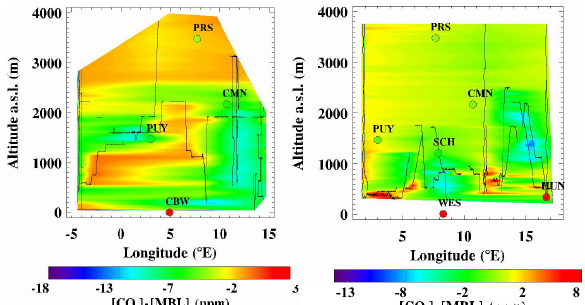
Fig. 10. Interpolation of the CO 2 concentrations for the whole cam- paign and for each leg according to longitude and altitude during the CAATER 1 (left) and CAATER 2 (right) campaigns. The concen- tration scale refers to the MBL background concentration of each campaign, as defined in the text. Flight paths are shown in black. Ground station concentrations, averaged in Sect. 1, are shown at the respective station coordinates. Note that for plot convenience, HUN and WES stations during CAATER 2 are shown as being at the max- imum of the chosen concentration scale, while indeed they show even higher concentrations (respectively: 12.7ppm and 38.5ppm above the marine background concentration, defined in Sect.